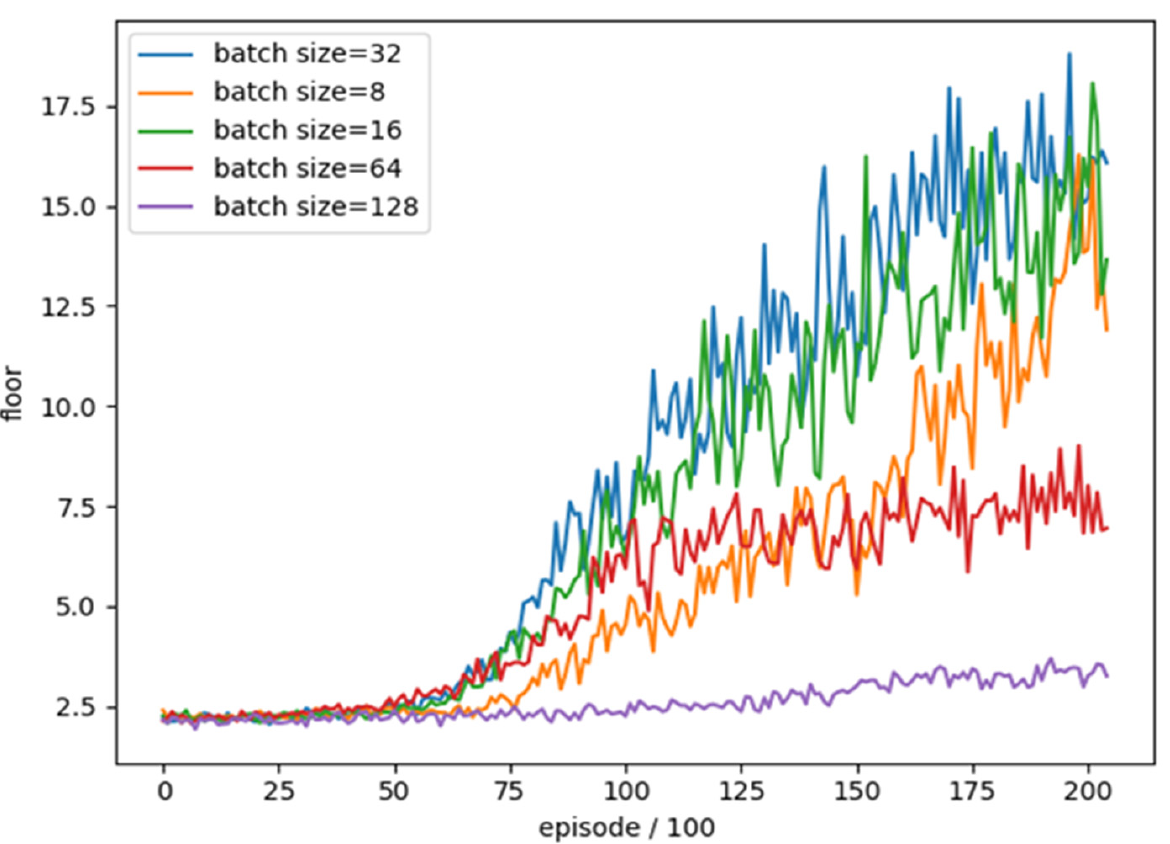
Figure 14. The training trend of Mini-batch size in different setting. We can see that the effectiveness of training with too high batch size (64, 128) is much lower than others and cannot achieve a good result in the end, while the amplitude of vibration during training with too low batch size (8) is compared others are larger. Average number of reached floors in the best 100 rounds for different frame skipping settings is shown in Table 12. The results show that the moderate batch size (32) in this experiment is a better setting, so we use batch size (32) as the final training parameter. Table 12. Average number of reached floors in the best 100 rounds for different frame skipping settings. Average Number of Reached Floors in Mini-Batch Size Settings